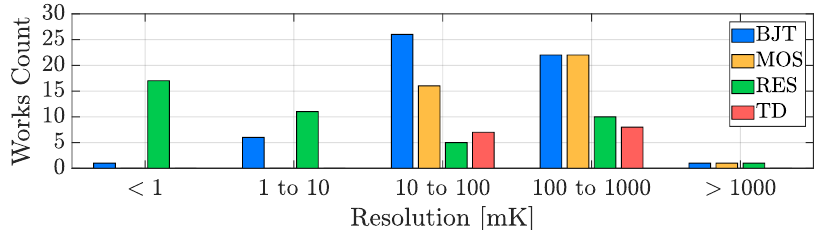
Figure 11. TDC resolution performance distribution with sensing-type